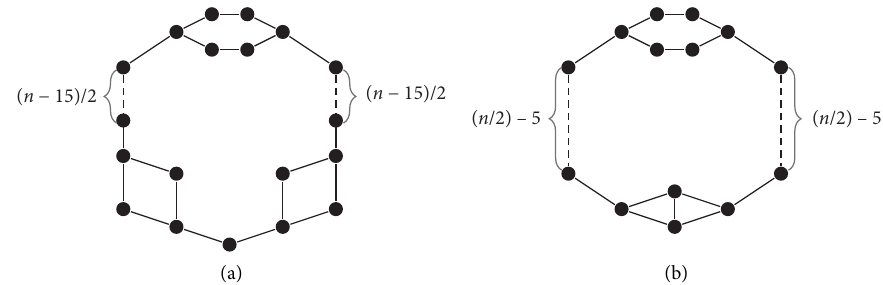
Figure 15: Tetracyclic graphs with minimum edge Mostar index of order n ( ≥ 19 ) . (a) G